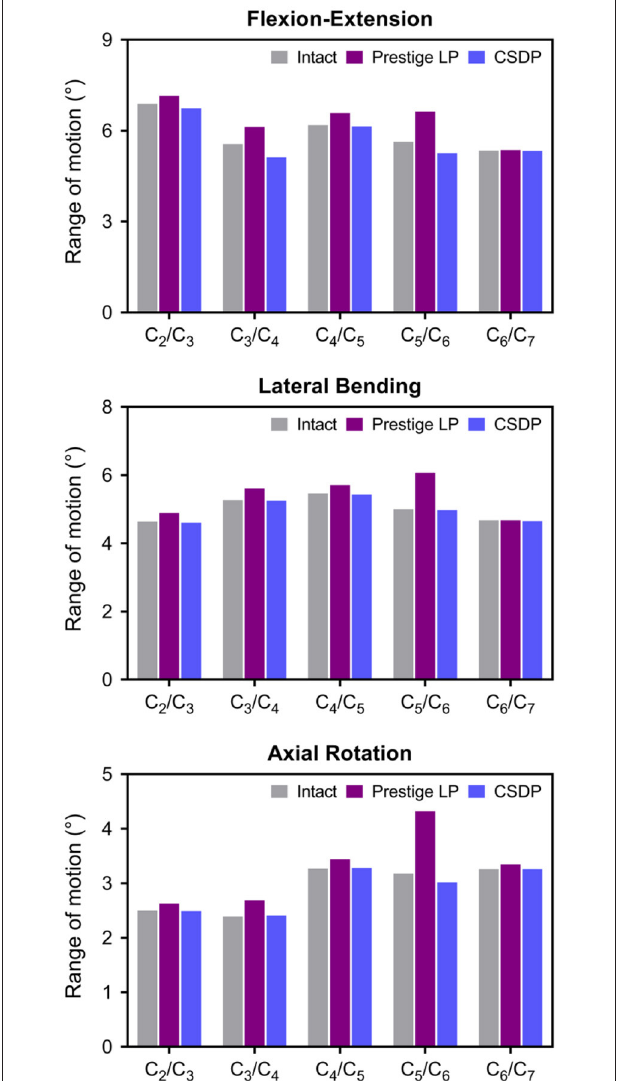
FIGURE 6 | Range of motion (ROM) of intact finite element (FE) cervical spine model and cervical artificial disc replacement (CADR) FE models. In three loads, no significant differences were found at the C 5 -C 6 level and other segments between the intact FE and cervical subtotal discectomy prosthesis (CSDP) FE models. ROM at the C 5 -C 6 level was higher in the Prestige LP FE model than in the intact and CSDP FE models.